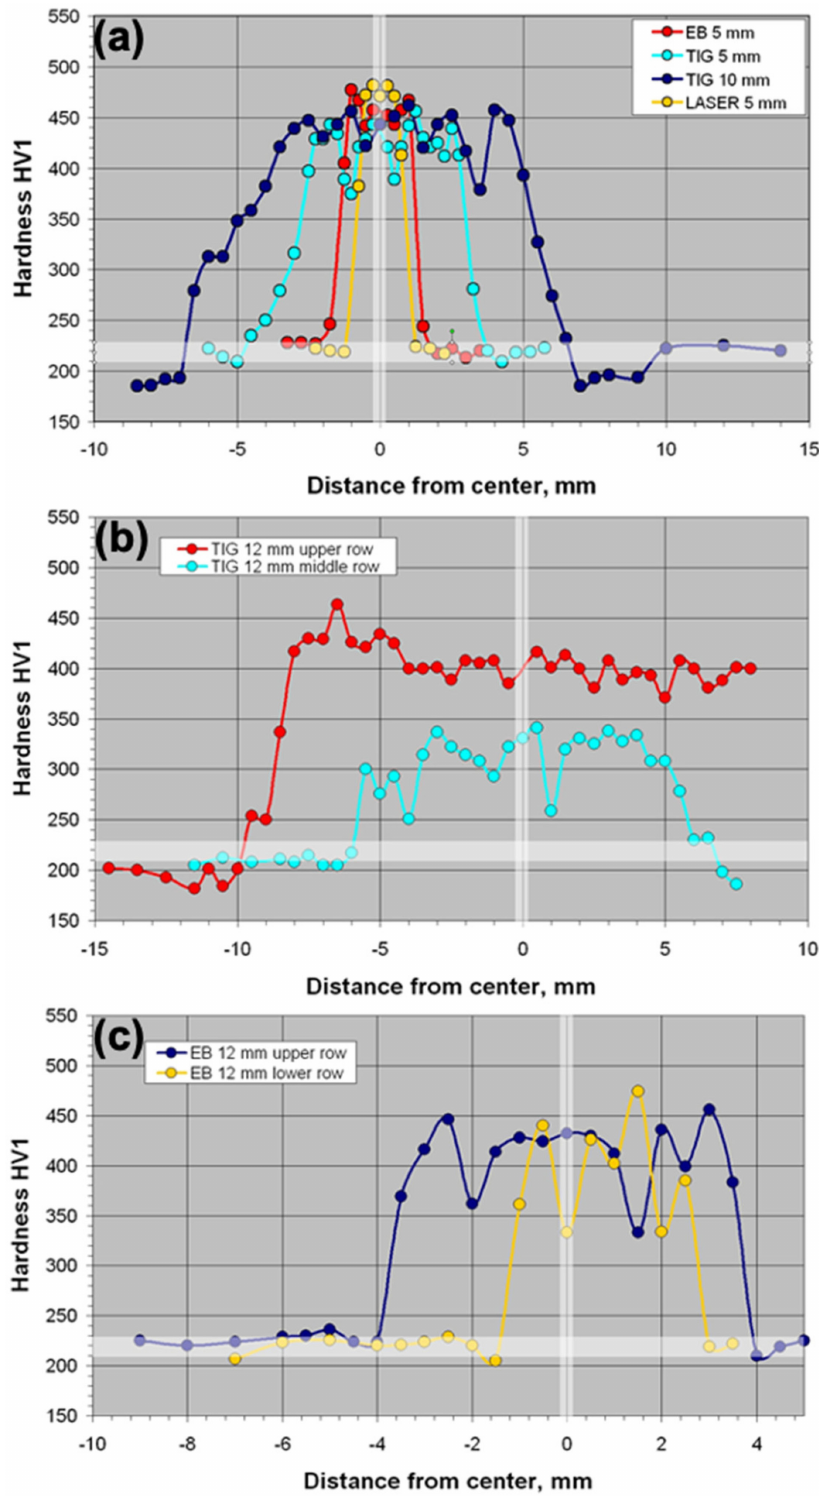
Figure 12. ( a ) Hardness profiles of 5 mm TIG, EB, and laser welds, and of the 10 mm TIG weld. The hardness level of the base material is shaded grey; ( b ) hardness profile of the 12 mm TIG weld from the top and middle cross-sectional part; ( c ) hardness profile of the 12 mm EB weld from the top and lower cross-sectional